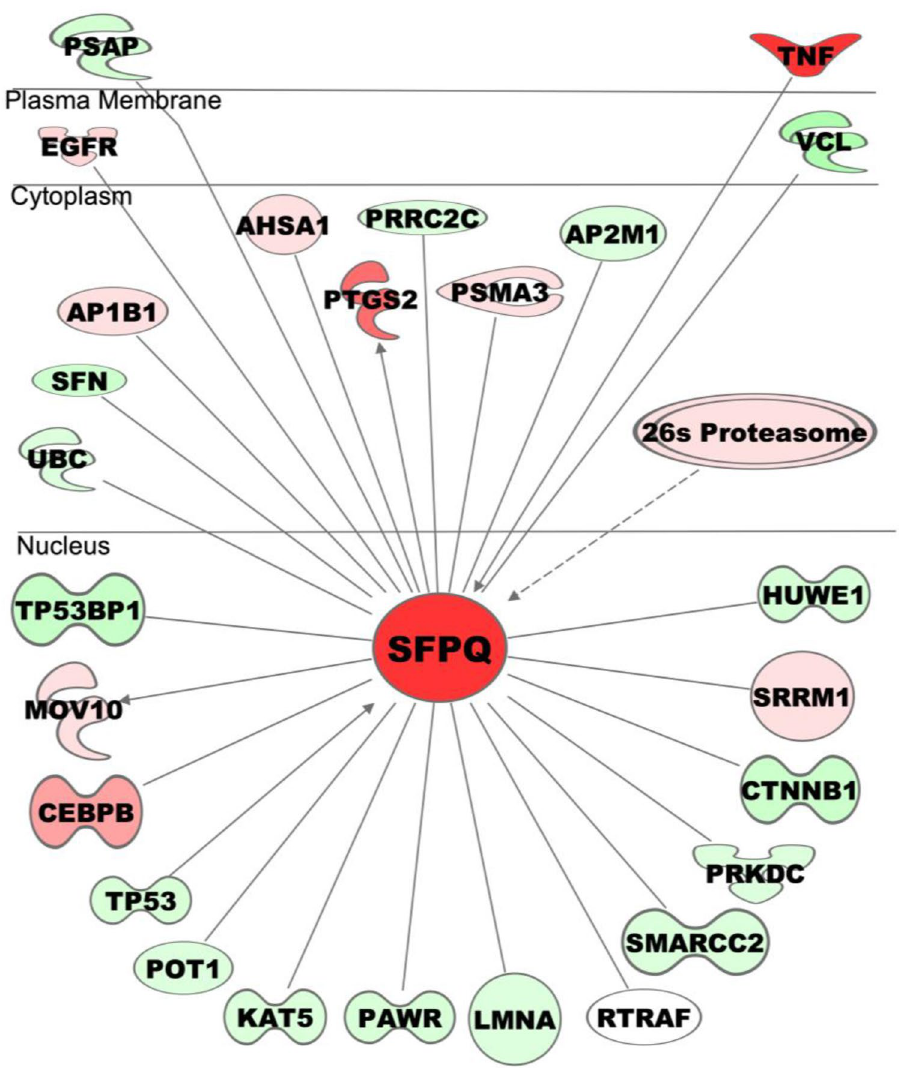
Figure 6. Effect of SFPQ overexpression on CFTR function. The SFPQ focused gene network represents DEGs that are associated with the rescue of CFTR expression, trafficking, maturation and